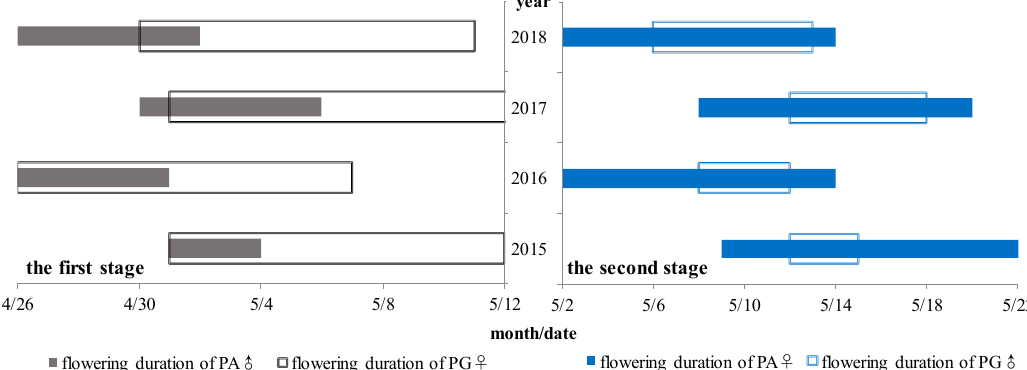
Figure 5. Flourish flowering duration ( > 50% individuals of PA and PG in bloom) of two stages in the population of C. paliurus.